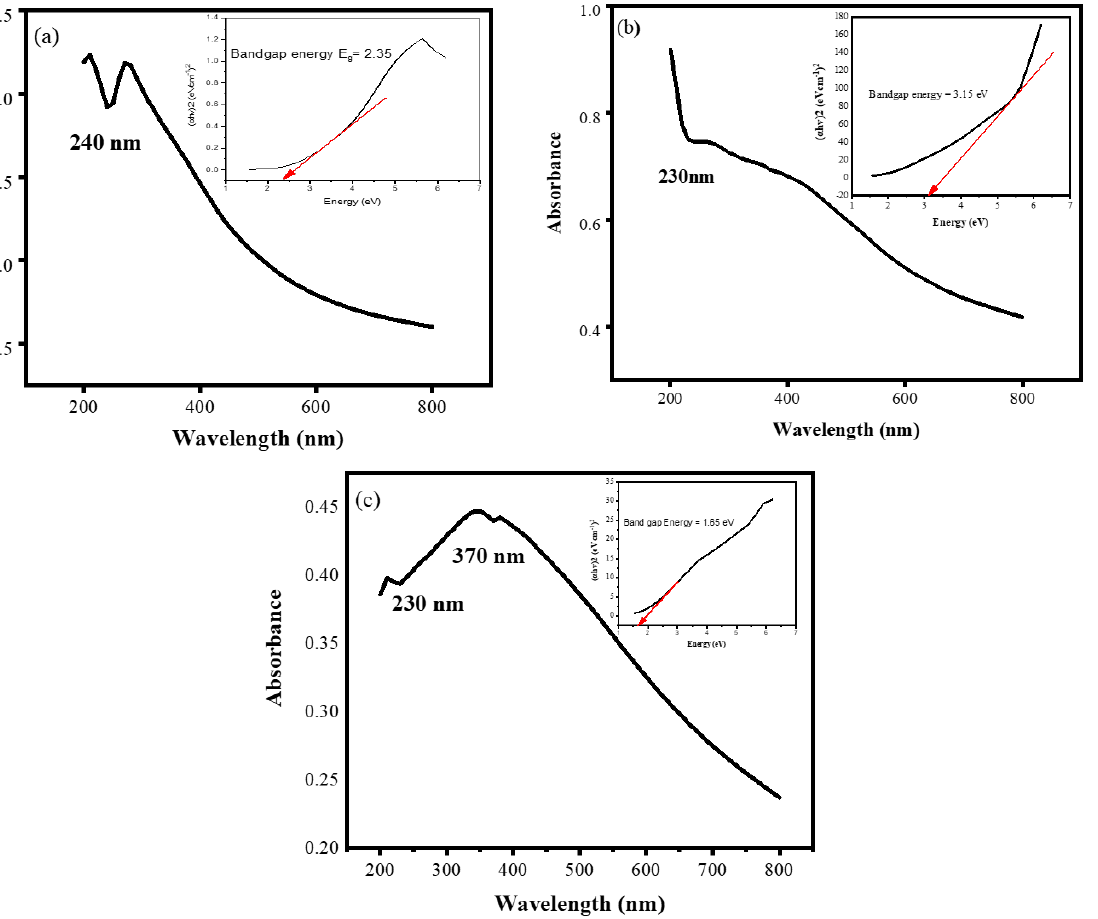
Figure 4. UV–Vis spectra of ( a ) Mn 3 O 4 NPs, ( b ) NiO NPs, and ( c ) Mn 3 O 4/ NiO NC 1:1 with bandgap energy.